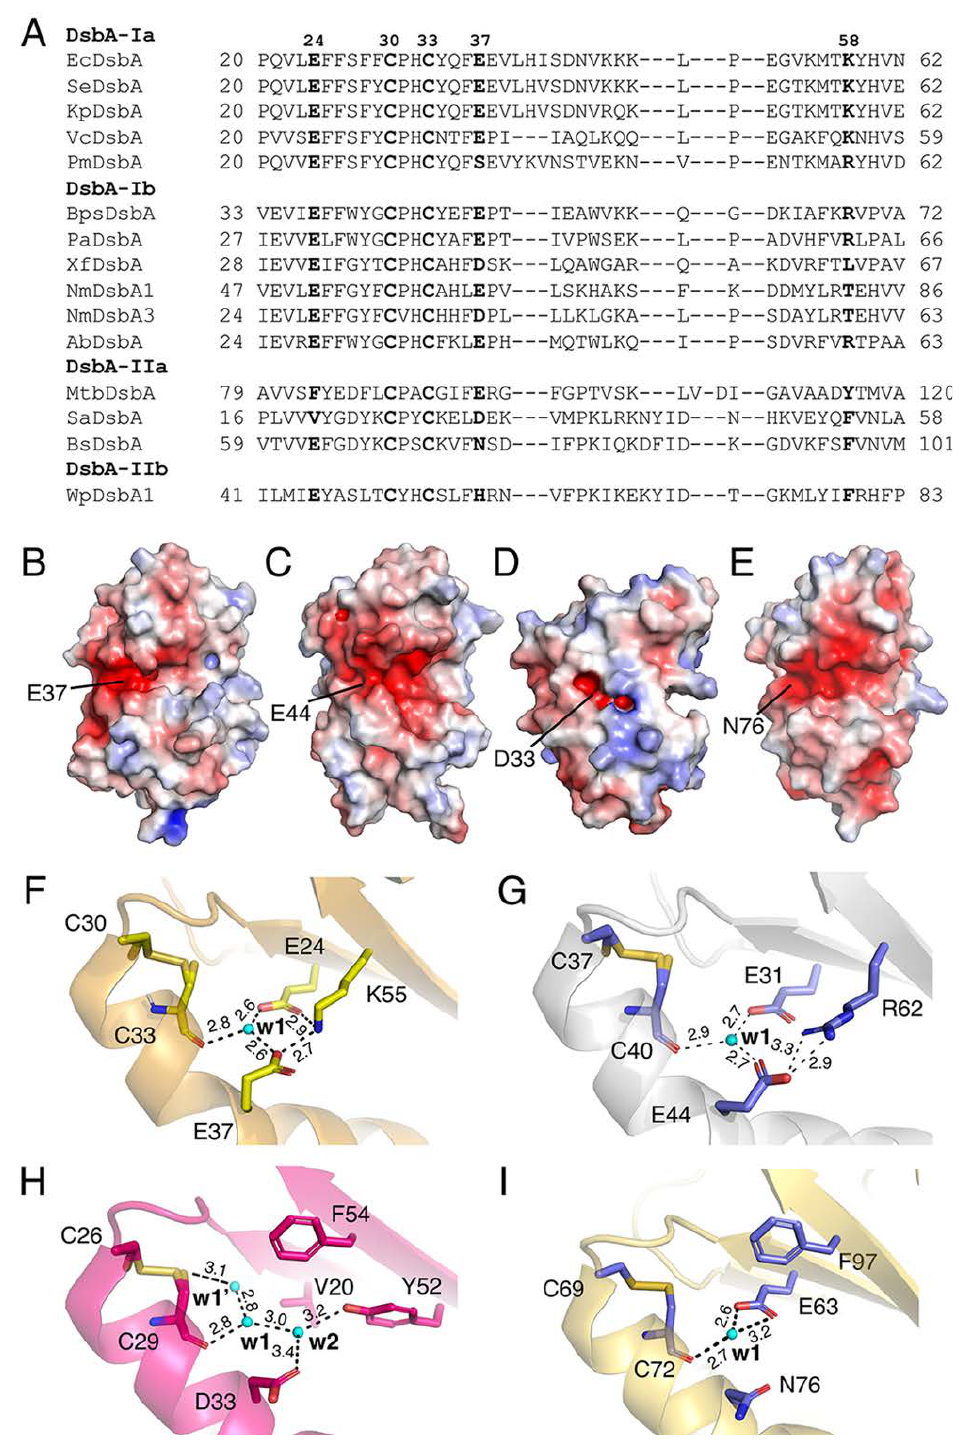
Figure 2. Conservation of charged residues, charged patch and water-mediated proton wire in DsbA proteins. ( A ) Alignment of representative DsbA from each structural class. ( B – E ) Electrostatic surface representation of the non-catalytic surface of DsbA from E. coli (PDB ID: 1FVK) ( B ), P. aeruginosa (PDB ID: 3H93) ( C ), S. aureus (PDB ID: 3BCI) ( D ) and B. subtilis (PDB ID: 3EU3) ( E ). Electrostatic surface potential is contoured between −5 (red) and +5 (blue) kT/e. Solvent-exposed E37 of EcDsbA and its equivalents in other DsbAs are labelled. ( F – I ) Possible water-mediated proton wire present in V. cholera DsbA ( F ), P. aeruginosa DsbA ( G ), S. aureus DsbA ( H ) and B. subtilis DsbA ( I ). In each case, a bound water labelled w1 forms hydrogen bonds with the buried C-terminal active site cys- teine and charged residues similar to those observed in EcDsbA. Unlike the structure of EcDsbA which has 3–4 water molecules in the buried channel, most DsbA structures from other bacteria